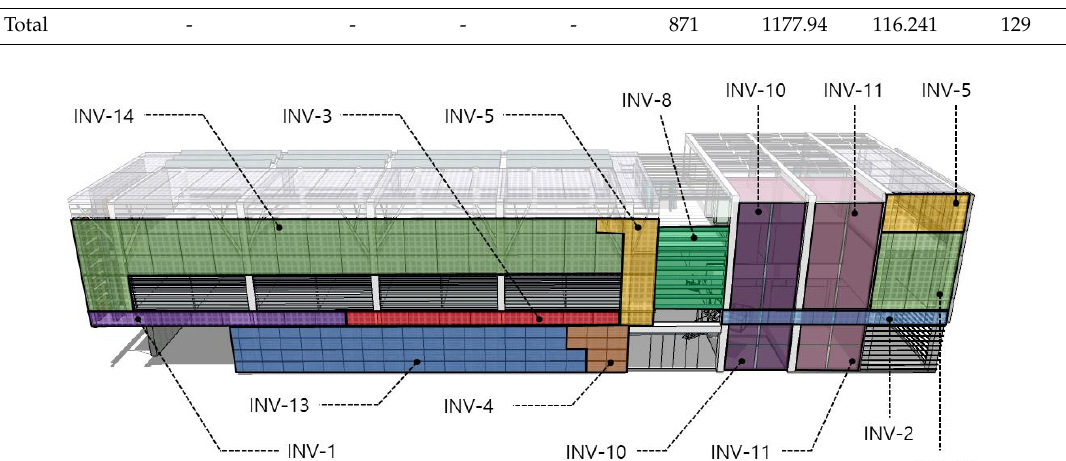
Figure 2. Detailed diagram of the building-integrated photovoltaic (BIPV) array installation on the southern façade of the Carbon Zero Building.